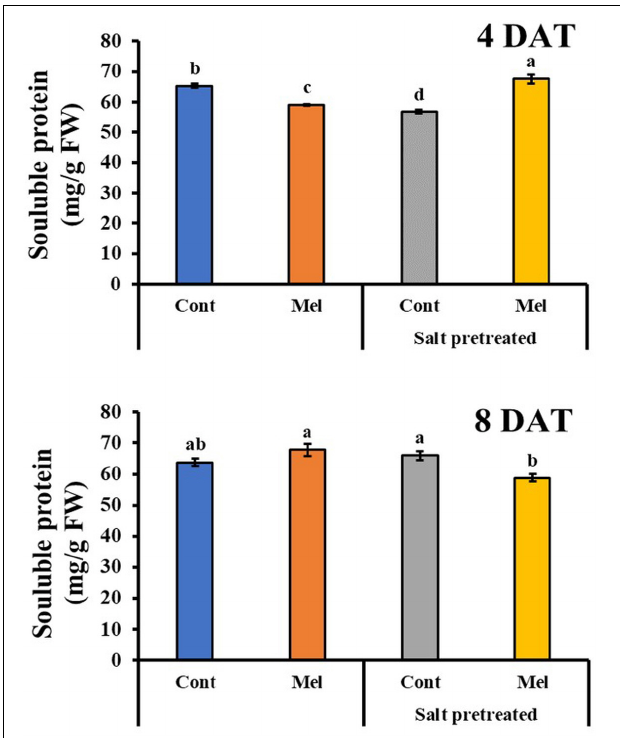
FIGURE 10 | Effect of melatonin with/without salt stress on protein content in green mustard seedlings. The results were calculated from data for 4 (4DAT) and 8 (8DAT) days. Treatment: control + water, control + 1 µ M melatonin, 150 mM salt pre-treatment + water, 150 mM salt pre-treatment + 1 µ M melatonin. Values show the means ± SE ( n = 3). Letters represent significant differences at p < 0.05 in accordance with Duncan’s multiple range